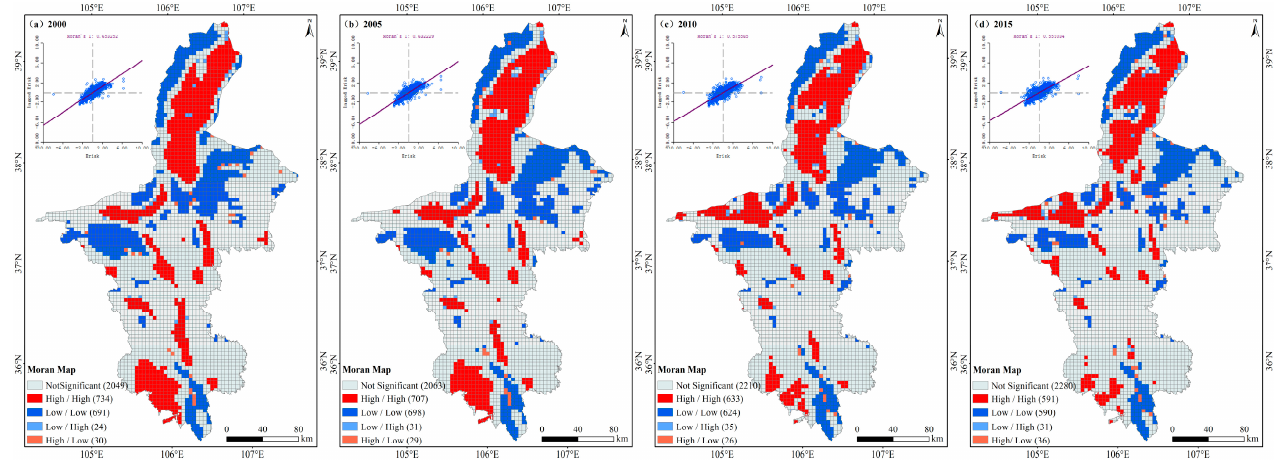
Figure 7. Moran scatter plot map and LISA aggregation map of LER in Ningxia from 2000 to 2015.